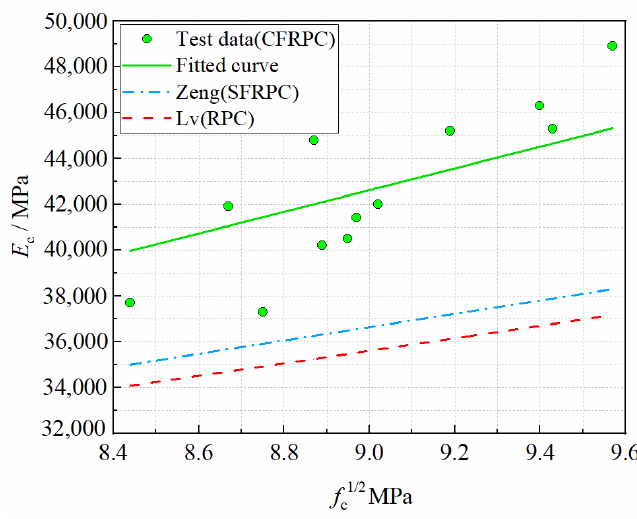
Figure 22. Relationship E c vs. f c.